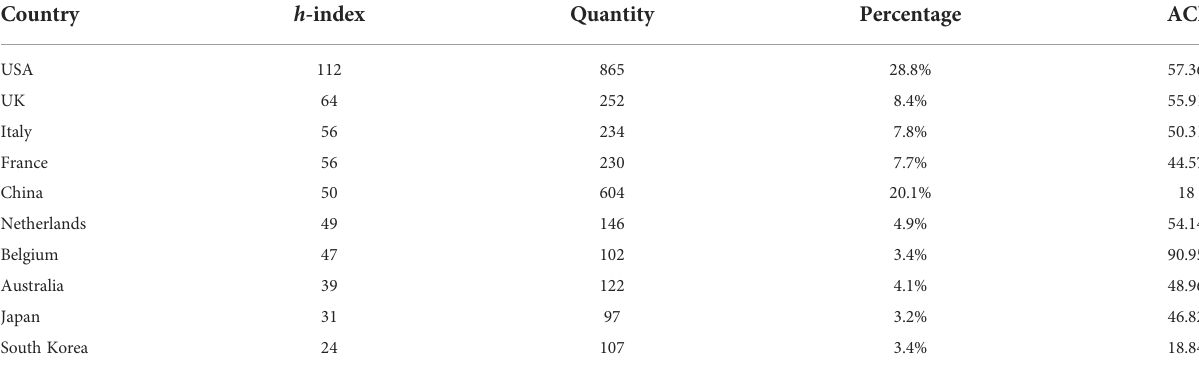
TABLE 1 Top 10 productive countries regarding the research on POI in terms of the h -index. Country